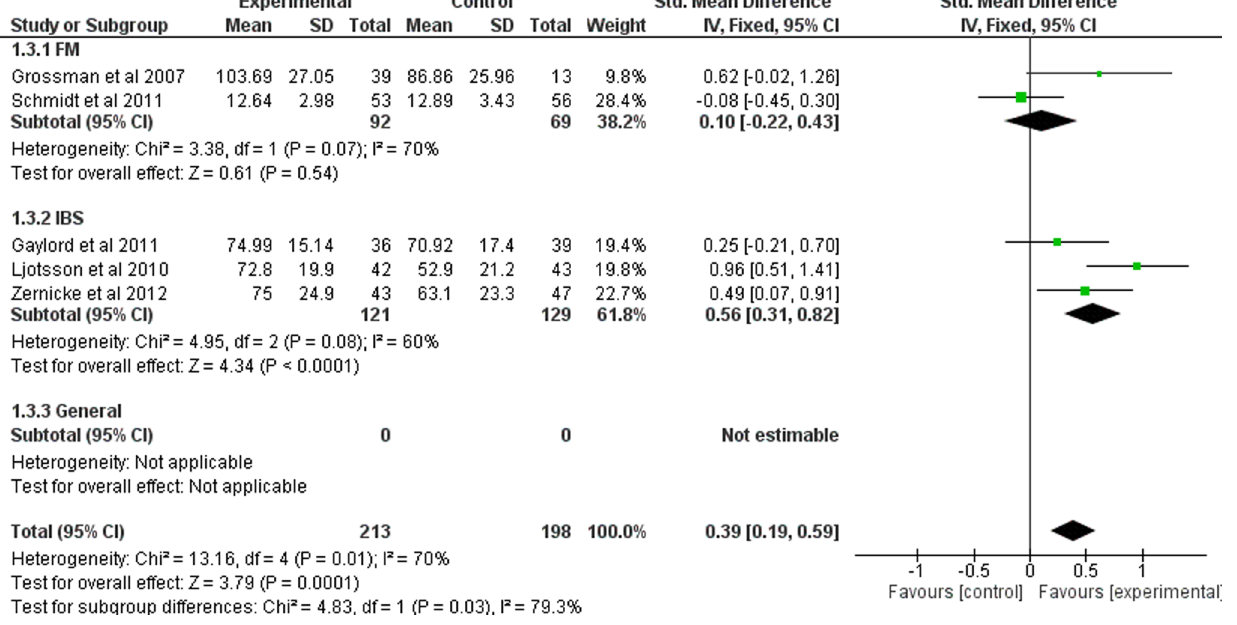
Figure 10. Forest plot showing the effect of mindfulness therapy on the quality of life outcome measure. Standardised mean difference between experimental and control group indicates that the mindfulness-based therapy group showed significantly more improvement than the control group, in only IBS.